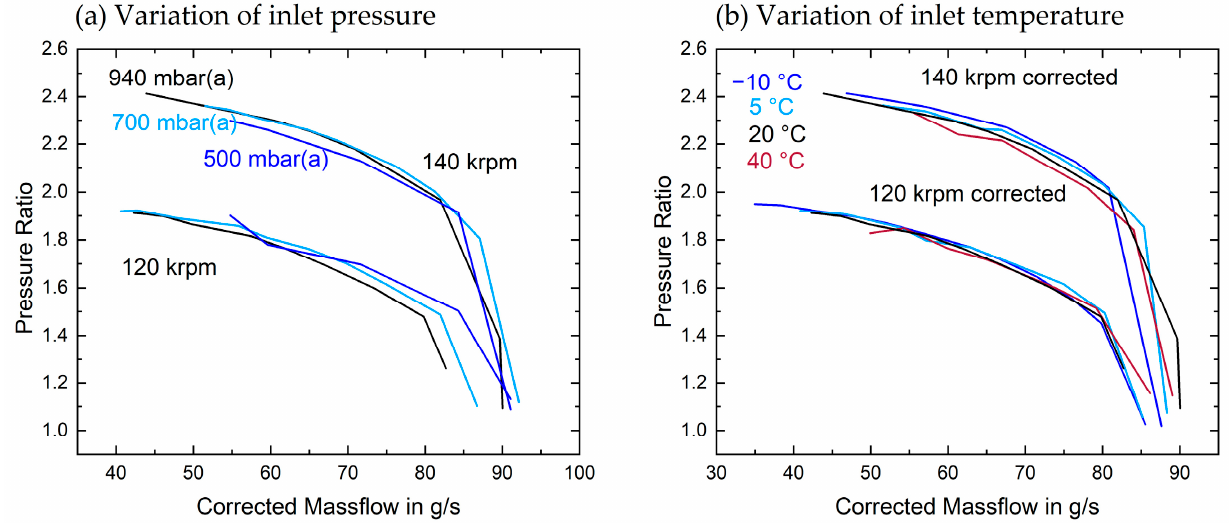
Figure 4. ( a ) Pressure ratio over corrected mass flow for measurements with 940 mbar(a) (black), 700 mbar(a) (light blue) and 500 mbar(a) (dark blue) inlet pressure at 20 °C, corrected to 20 °C and 940 mbar(a). ( b ) Pressure ratio over corrected mass flow for measurements with − 10 °C (dark blue), 20 °C (black), 5 °C (light blue) and 40 °C (red) inlet temperature at 940 mbar(a), corrected to 20 °C and 940 mbar(a).